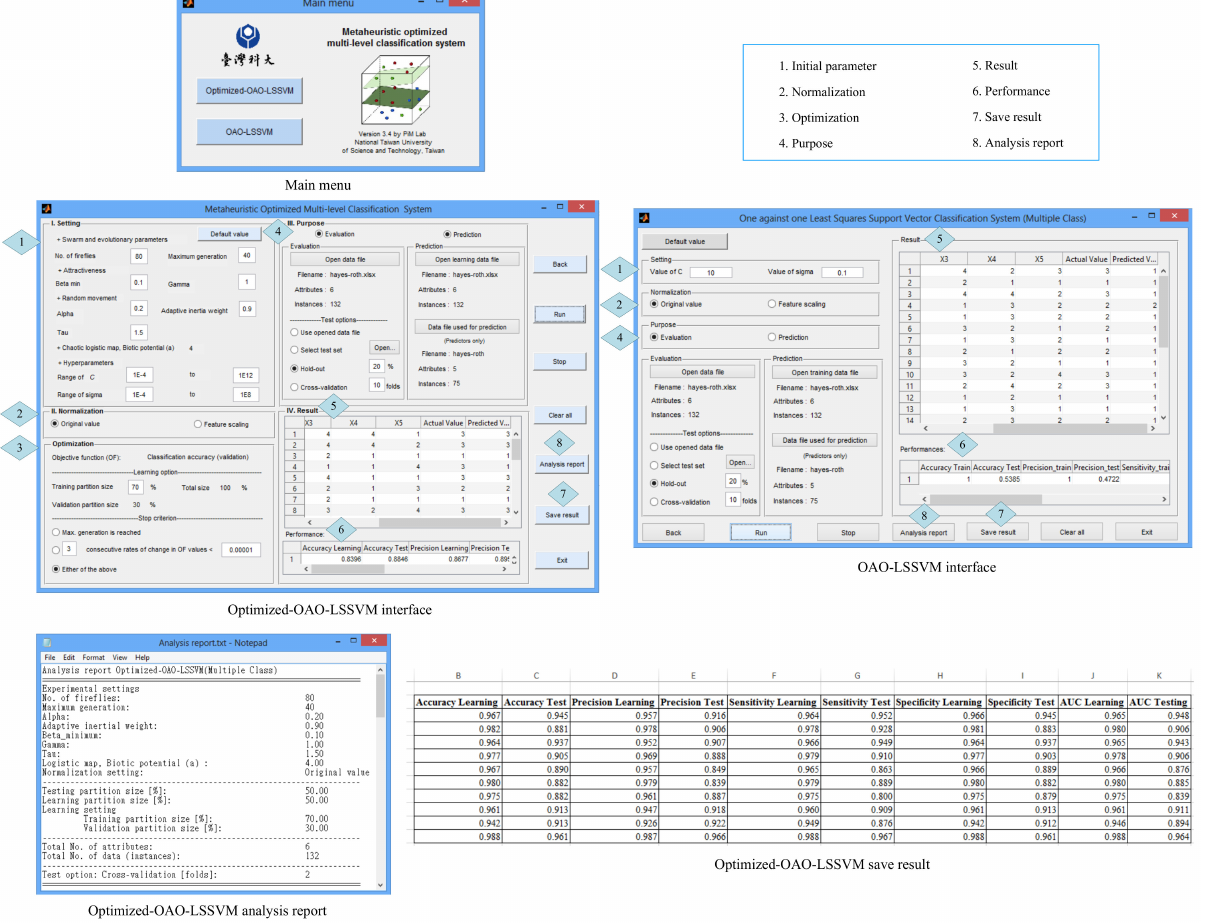
Figure 2. Screenshots of